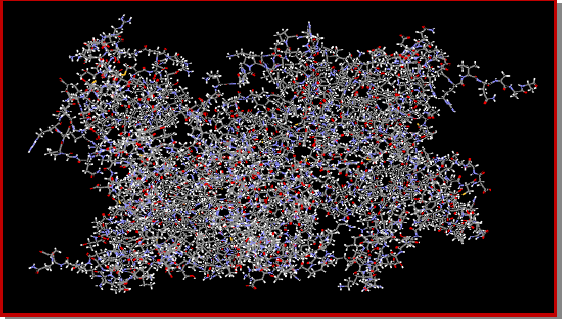
Figure 1: The refined structure of tau protein kinase I